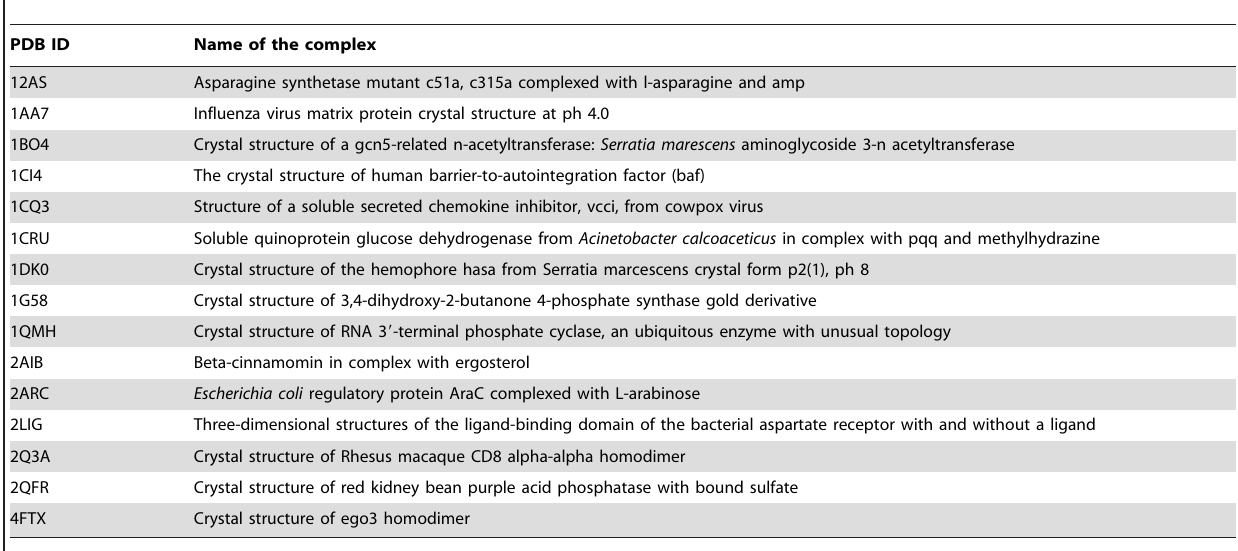
Table 4. List of 15 homodimers (chain A and B) used for testing DockScore.